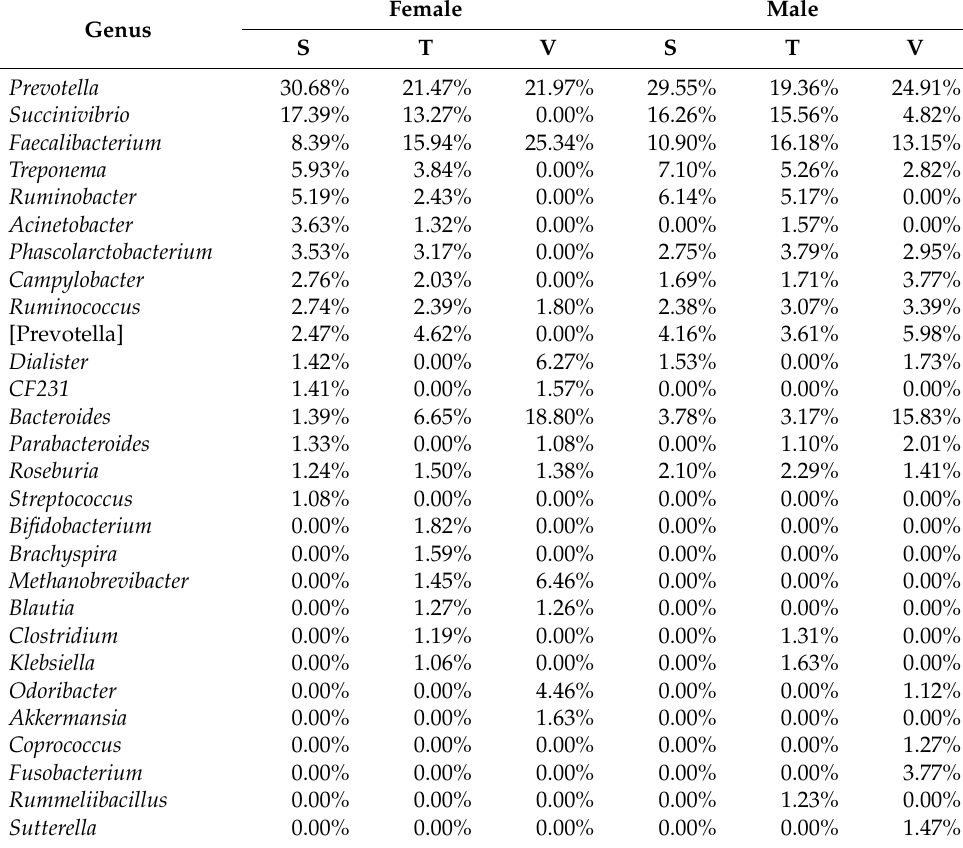
Figure A2. Significant pathways. ( A ) Arginine and proline metabolism, ( B ) lipopolysaccharide biosynthesis, ( C ) glycosphingolipid biosynthesis, ( D ) porphyrin and chlorophyll metabolism, ( E ) gly- cosyltransferases, ( F ) chaperones and folding catalysts, ( G ) bacterial toxins. Table A5. Genera distribution for the gender groups for the three locations: Siminke (S), Tezhumake (T), and Valledupar (V). Data indicate relative abundances (percentages of OTU counts). Genera with relative abundances lower than 1% were filtered